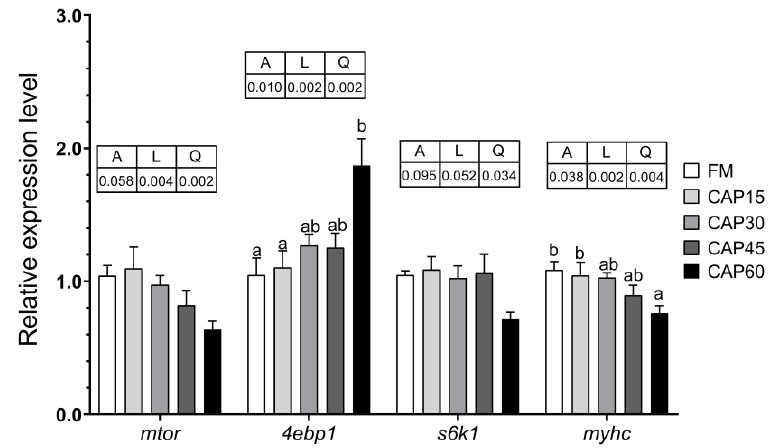
Figure 6. Relative mRNA expression level of protein synthesis-related genes in dorsal muscle of pearl gentian grouper fed gradient substitution of fishmeal in the diet with CAP. mtor , mammalian target of rapamycin ; 4e-bp1 , eukaryotic translation initiation factor 4E-binding protein 1 ; s6k1 , ribosomal protein S6 kinase 1 ; myhc , myosin heavy chain . Bars represent means ± pooled standard error of the mean (SEM), n = 4. Different superscript letters are significantly different ( p < 0.05) among treatments. Significance probability associated with the F-statistic. A: Analysis of Variance; L: analysis of Linear trend; Q: Analysis of Quadratic trend.